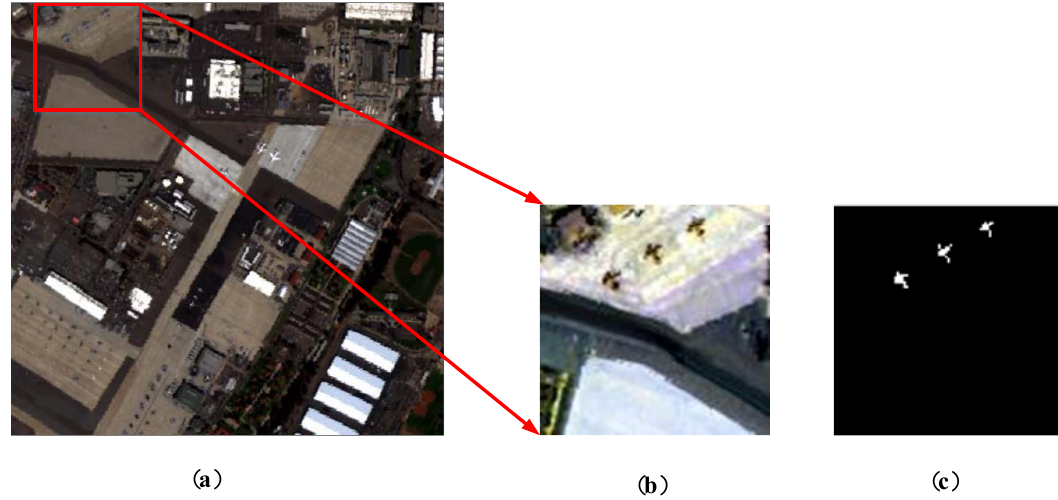
Figure 5. Descriptions of Airborne Visible/Infrared Imaging Spectrometer (AVIRIS)–I dataset. ( a ) False color image of the whole scene; ( b ) false color image of the detection area; ( c ) ground-truth of AVIRIS–I